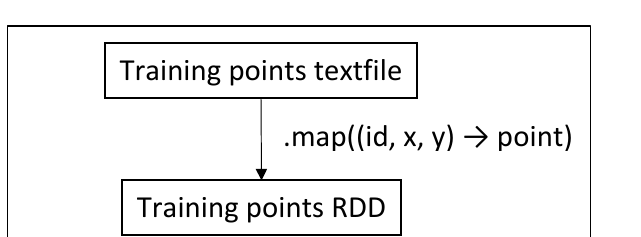
Figure 12. Starting Spark session.